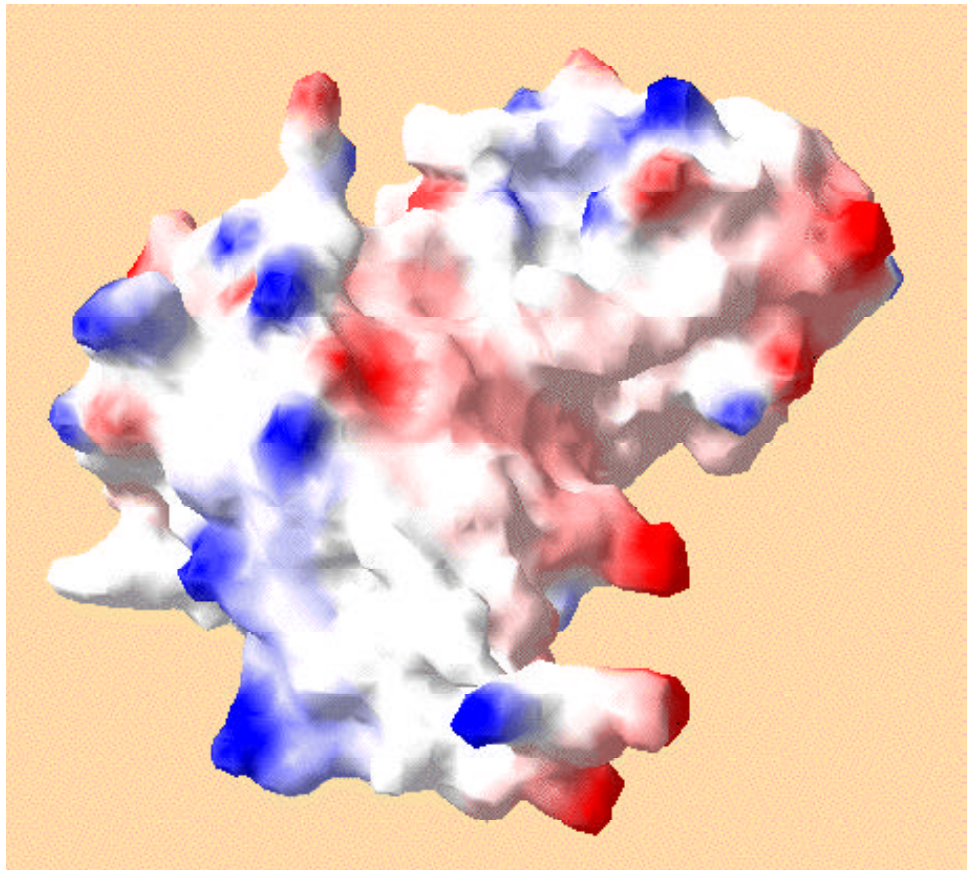
FIGURE 4. Electrostatic potential surface of an anti-HbsAg scFv fragment. Modelled from de 4fab and 1sbs using InsightII. Surface calculated with